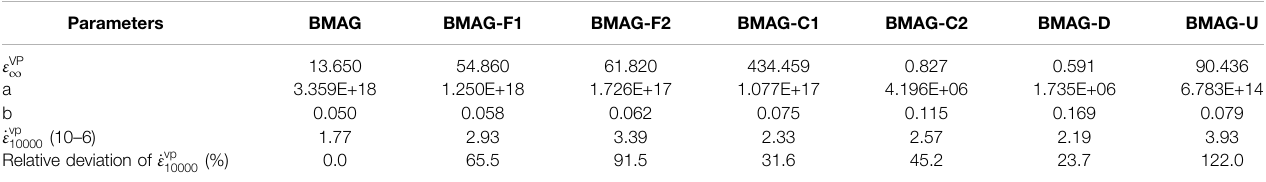
TABLE 6 | Viscoplastic strain parameters and high-temperature performance parameters of each gradated HMA.